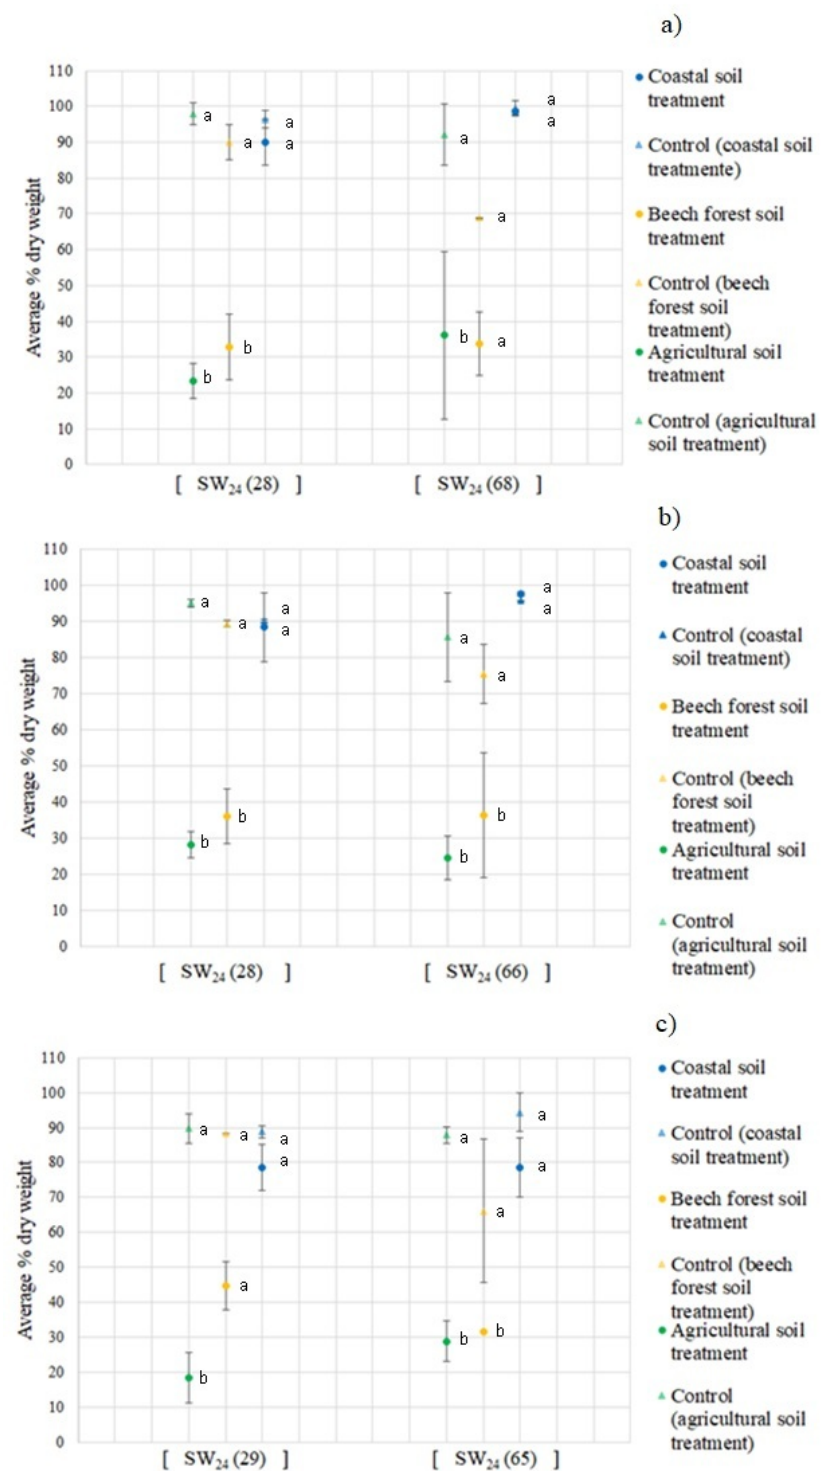
Figure 7. Average percentage dry weight at the end of the second degradation analysis experiment for the SW 24 value analyzed for the ( a ) 10% w / w of AHum suspension; ( b ) 30% w / w of AHum suspension; ( c ) 50% w / w of AHum suspension. Two different curing times, leading to two resulting SW 24 values which are inversely proportional to the curing time values are shown. Treatments sharing the same letter (within vertical comparisons) are not statistically significant for p < 0.05 (ANOVA; Tukey Post Hoc Test). Bars presents mean value ± standard deviation.